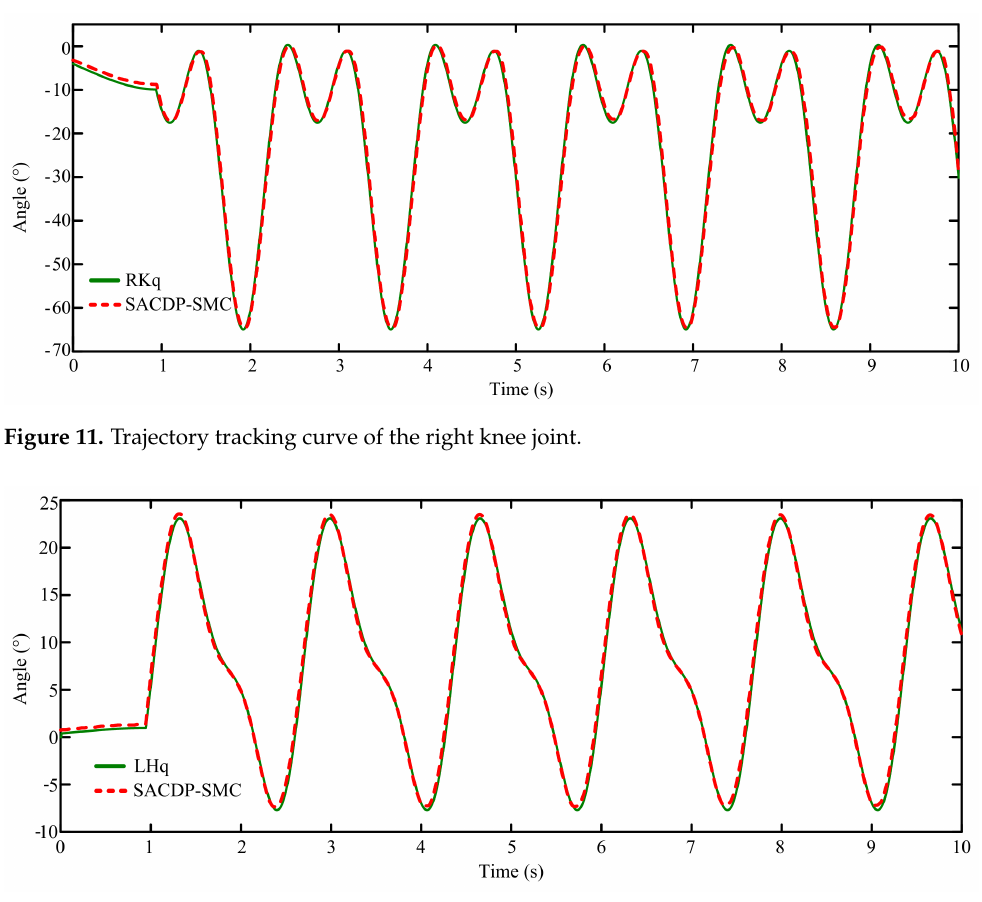
Figure 12. Trajectory tracking curve of the left hip joint.